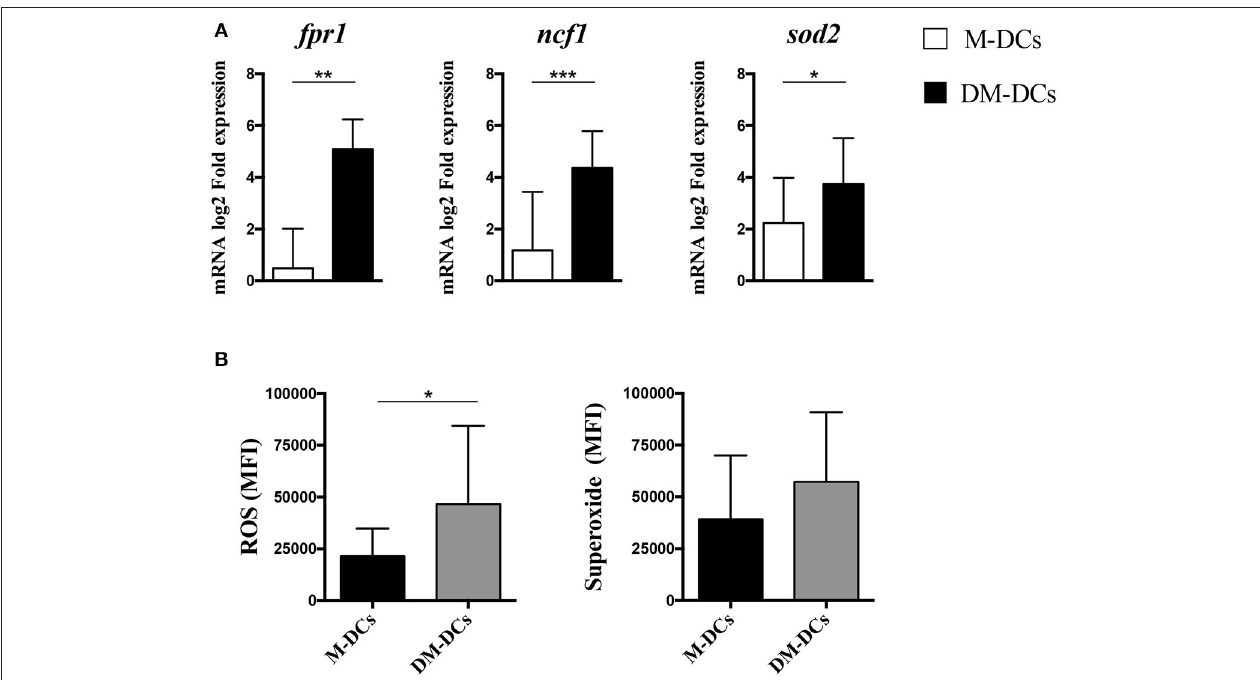
FIGURE 5 | Intracellular concentration levels of reactive oxygen species and superoxide anions is higher in Dex-modulated and MPLA-activated dendritic cells (DM-DCs) than in other DC subtypes. Enrichment of ROS production in DM-DCs compared to DCs and M-DCs was confirmed through gene expression analysis of associated molecules and determination of intracellular levels of free radicals. (A) Determination of mRNA levels of genes related to ROS and superoxide production and upregulated on DM-DCs was determined by real time PCR. Data shows fold expression values of DM-DCs and M-DCs relative to untreated DCs expression ( n = 10; * p = 0.05; ** p = 0.01; ** p = 0.001). (B) Total ROS and superoxide production in cells was assessed with two fluorescent cell-permeable reagents and flow cytometry analysis. Shown are MFI values for each probe reacting with ROS and superoxide ( n = 3; * p = 0.05, ** p = 0.01). DCs, untreated/immature DCs;